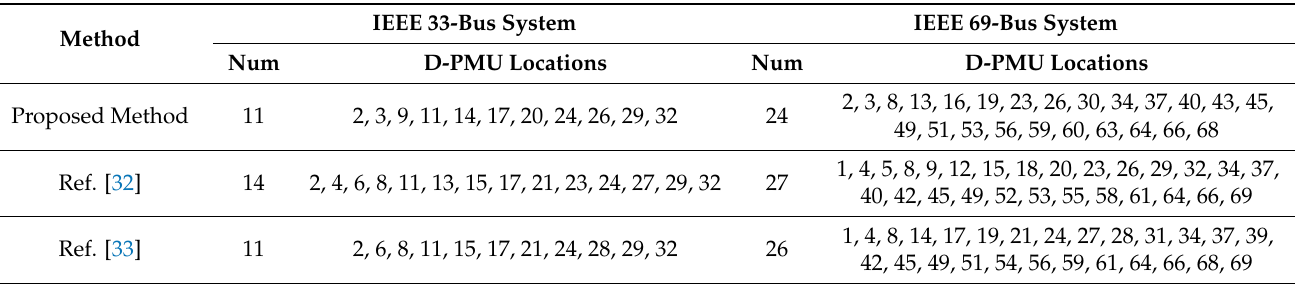
Table 2. Comparison of the minimum number of D-PMUs for complete observability.